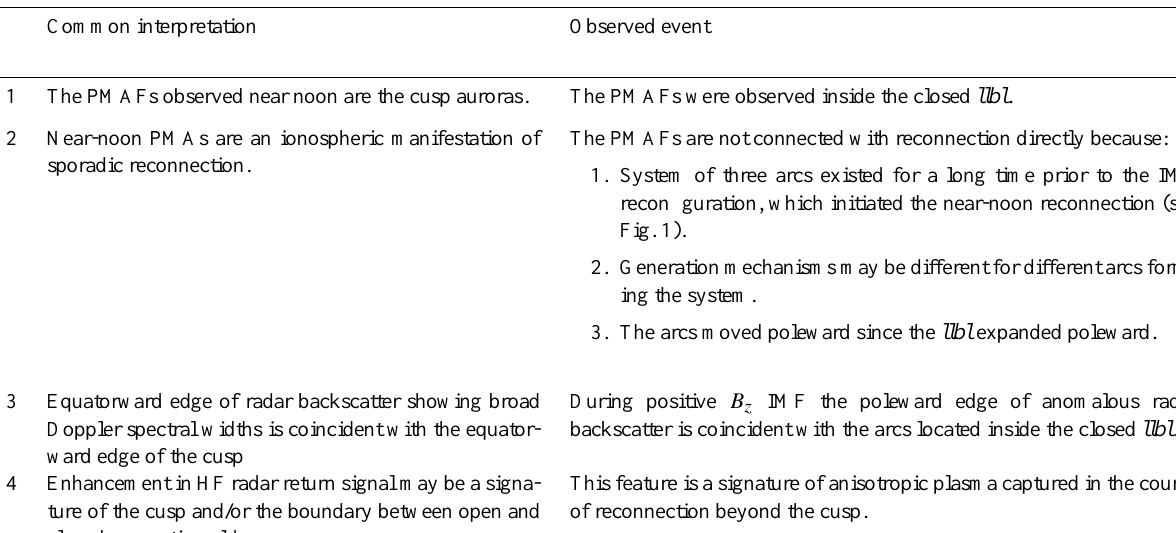
Table 1. Comparison of the interpretation of the event under study with widely-used